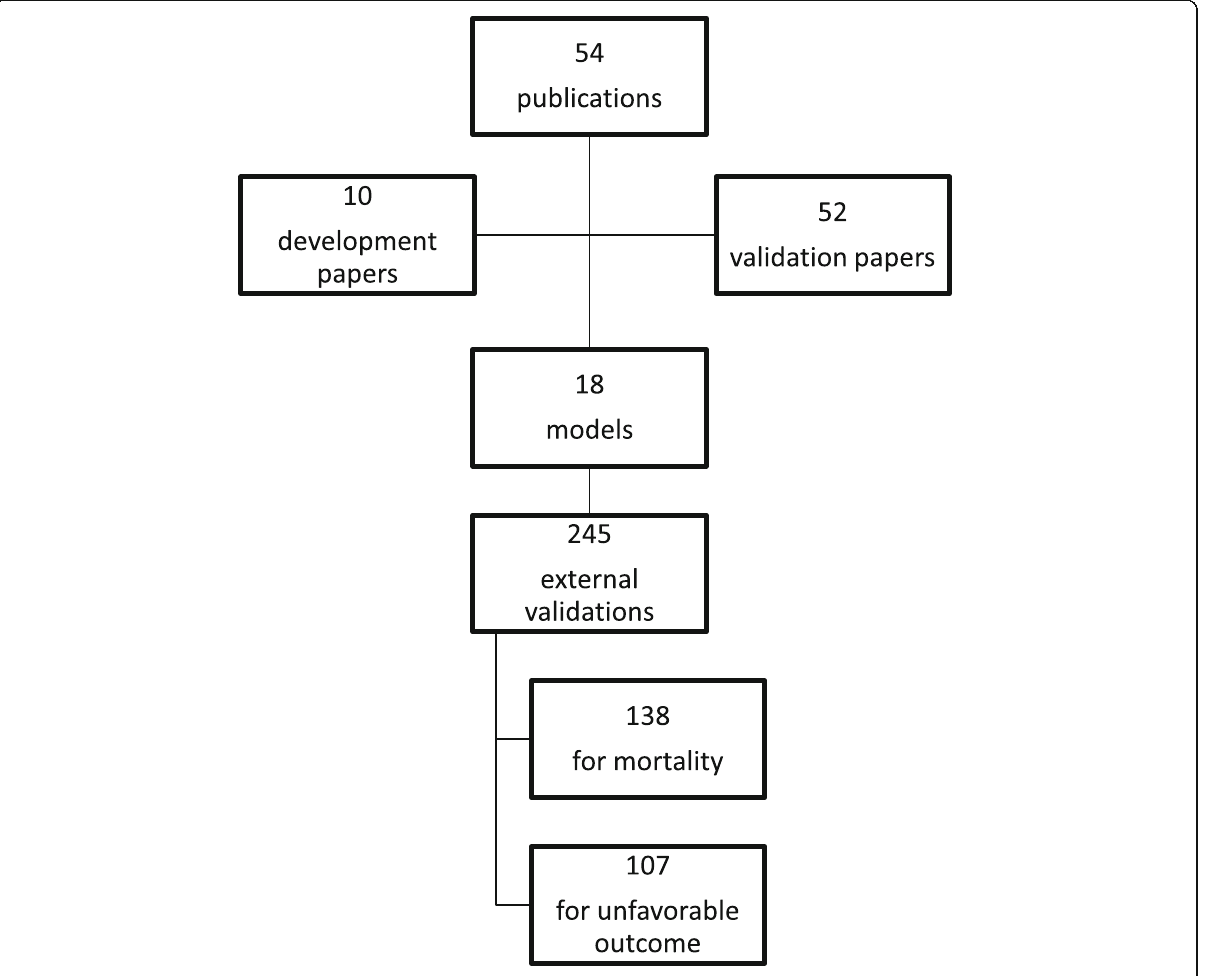
Fig. 1 Flow diagram of included studies based on the systematic